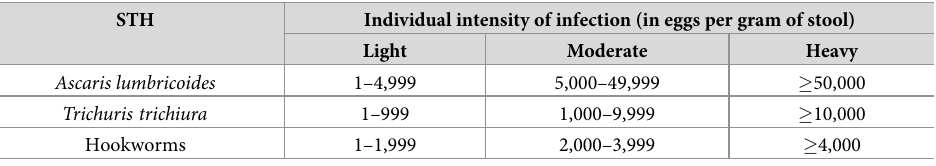
Table 3. Classes of intensity, based on Kato-Katz measurements [1].